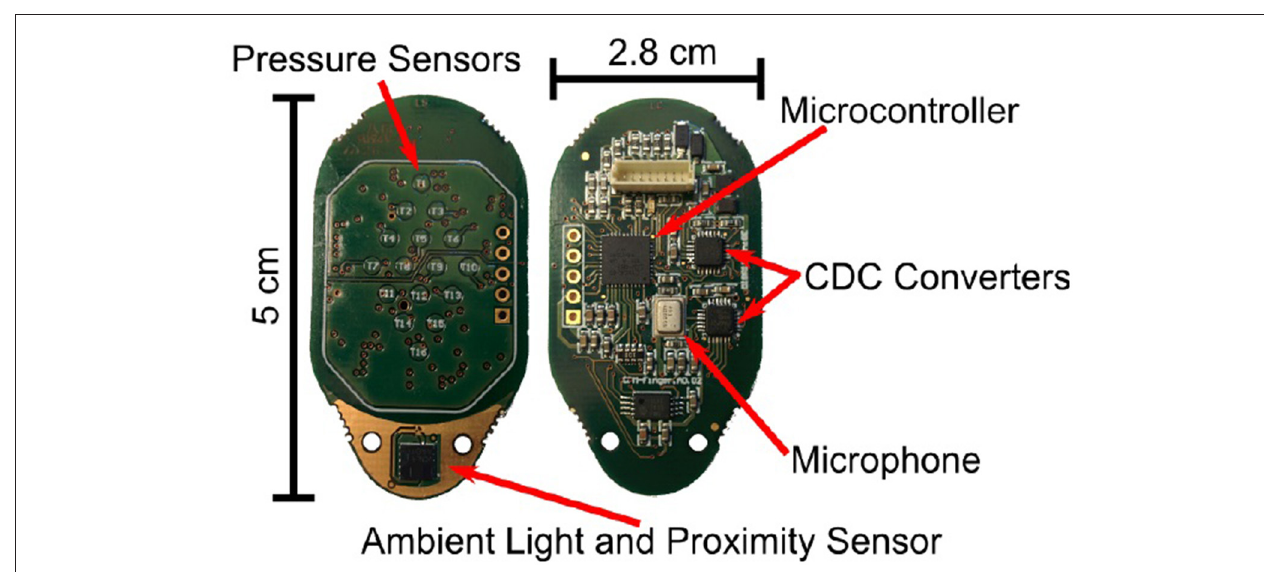
FIGURE 2 | The top and bottom view of the sensor circuit board. The side with the pressure sensors is in contact with the objects during experiments.